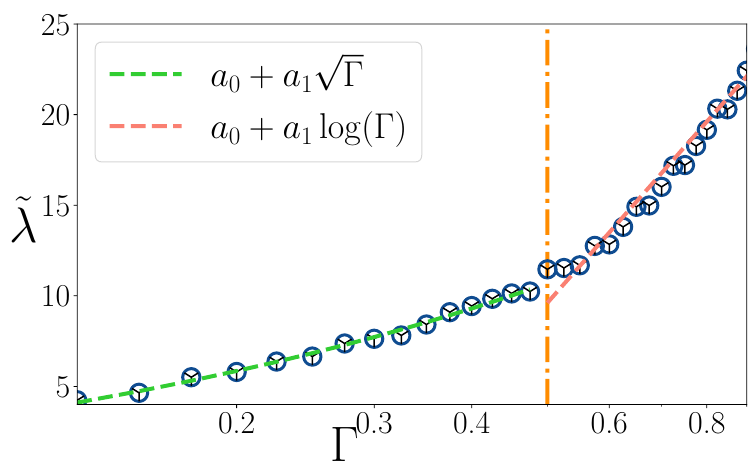
Figure 11: The new Lyapunov exponents extracted from the DOTOC commutators ˜ λ is plotted with rate. The dashed lines represent the fit obtained with rate Γ < 0.5 and Γ > 0.5. While the dotted-dashed line differentiates Γ =